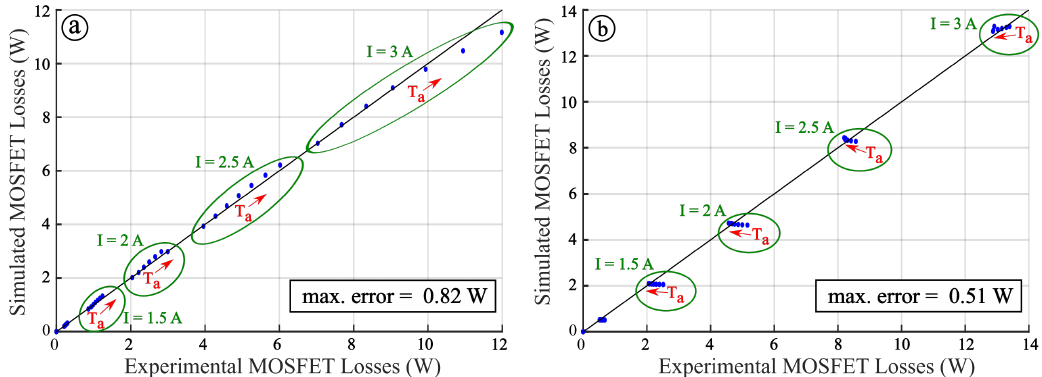
Figure 4. The experimental and the simulated steady-state power losses of the ( a ) cascode GaN MOSFET and the ( b ) SiC MOSFET when loaded by the same input